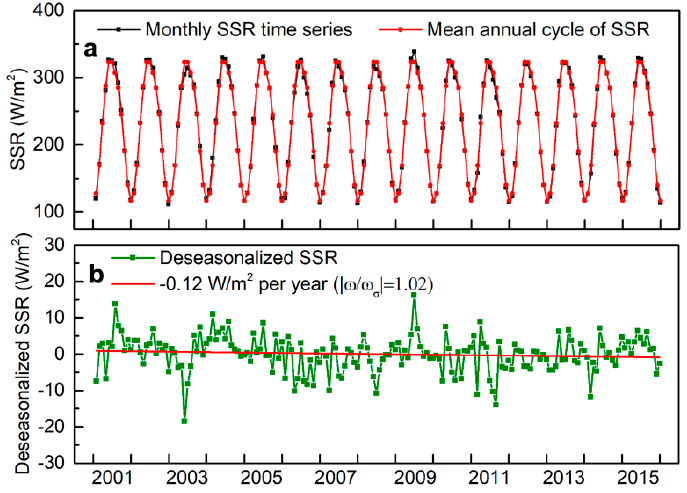
Figure 11. ( a ) Monthly clear-sky SSR time series and ( b ) deseasonalized clear-sky SSR trend in northern China from 2001 to 2015.